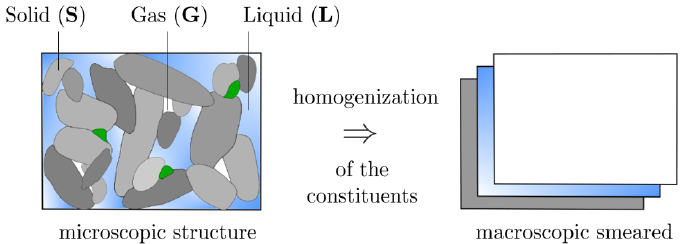
Figure 1. Representative elementary volume (REV) of the vadose zone and its